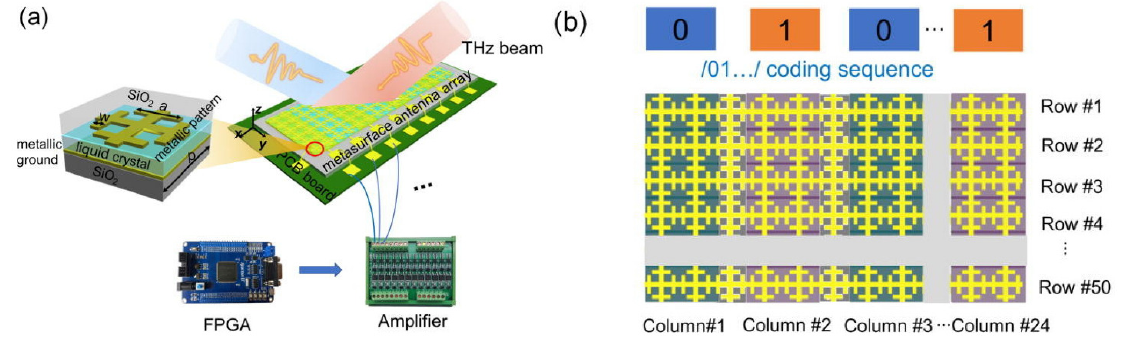
Figure 18. Cross-type programmable element grating. ( a ) Brief circuit schematic diagram. ( b ) Specific unit allocation control [29].